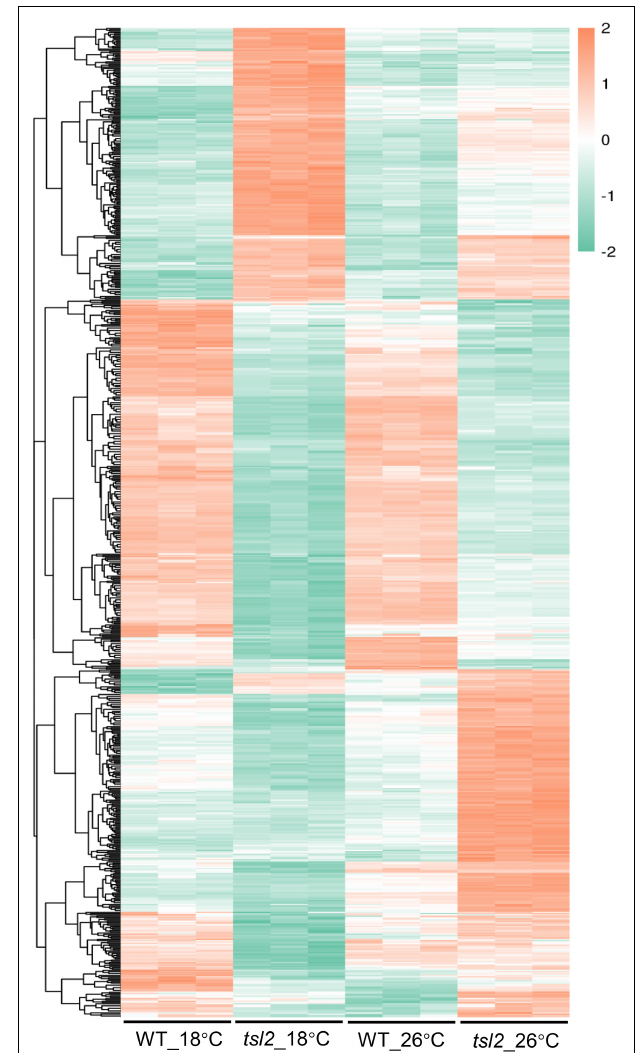
tsl2 is located in the AAA-ATPase domain. Expression of TSL2m in the WT resulted in yellowish true leaves, indicating the point mutation in tsl2 mutant impairs substrate/client protein recognition, and the mutated protein may interfere with the formation and/or function of the protein complex.